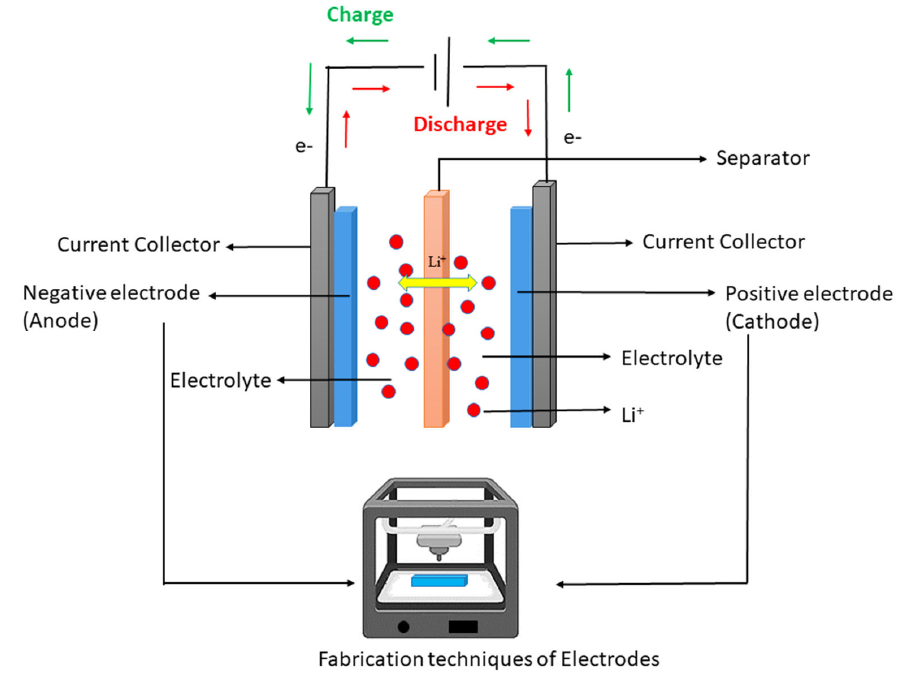
Figure 3. Schematic illustration of Li ion-based energy storage system. The components used in the Li ion-based energy storage system include the electro- lyte, separator and electrodes, i.e., positive electrode and negative electrode.